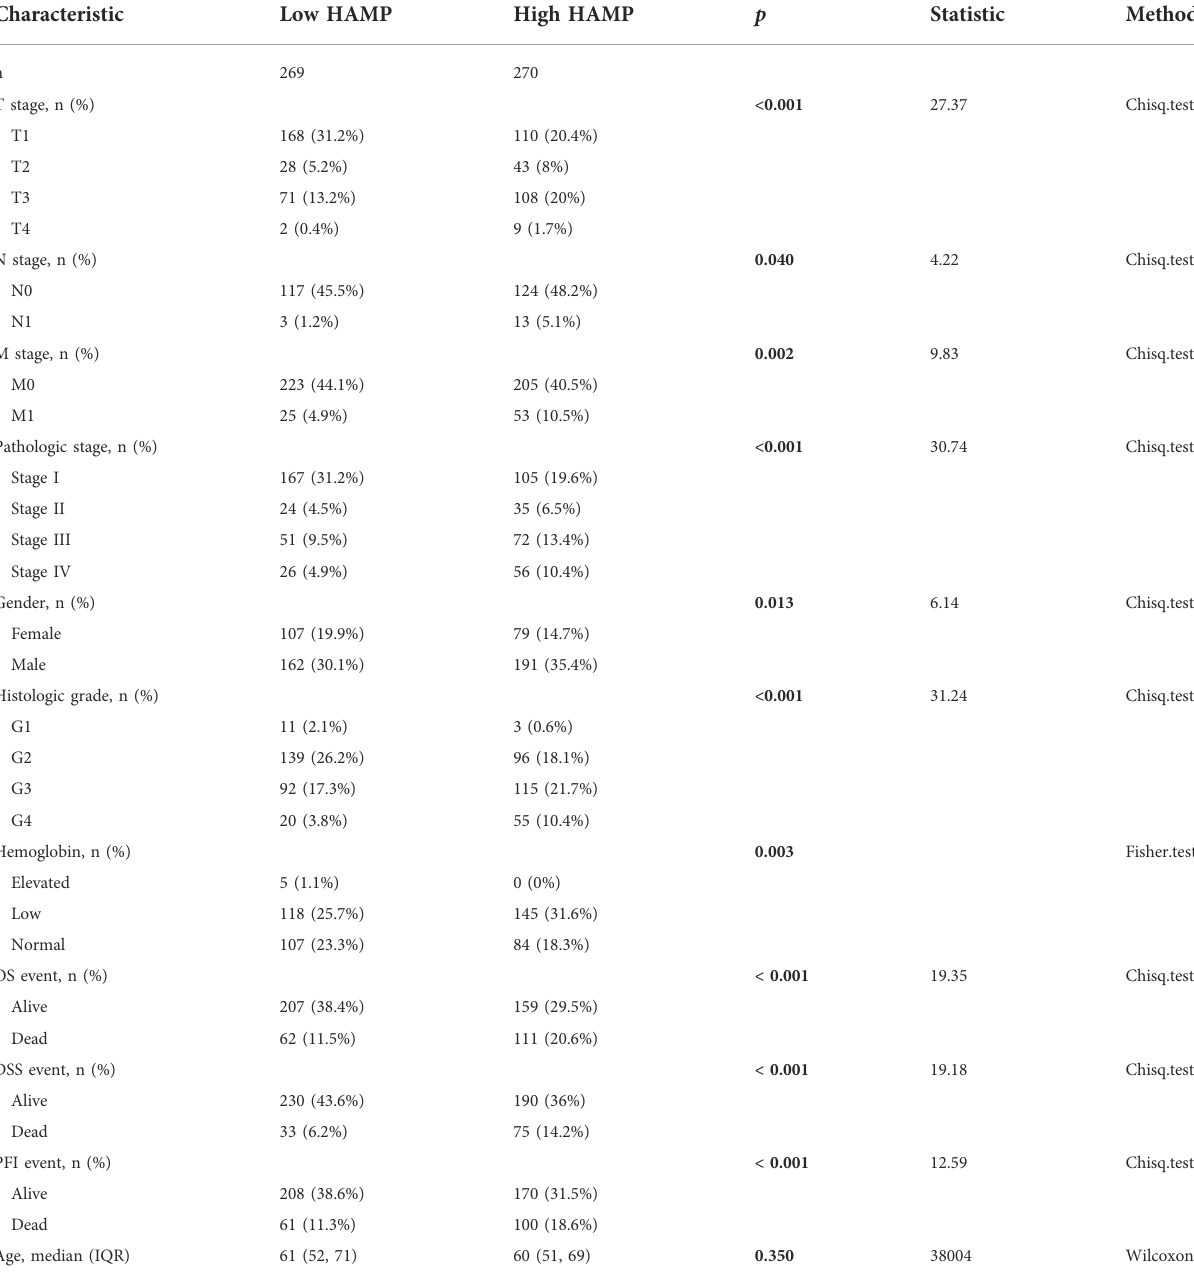
TABLE 1 Correlation of HAMP expression with c inicopathological parameters in ccRCC patients. Characteristic Low HAMP High HAMP